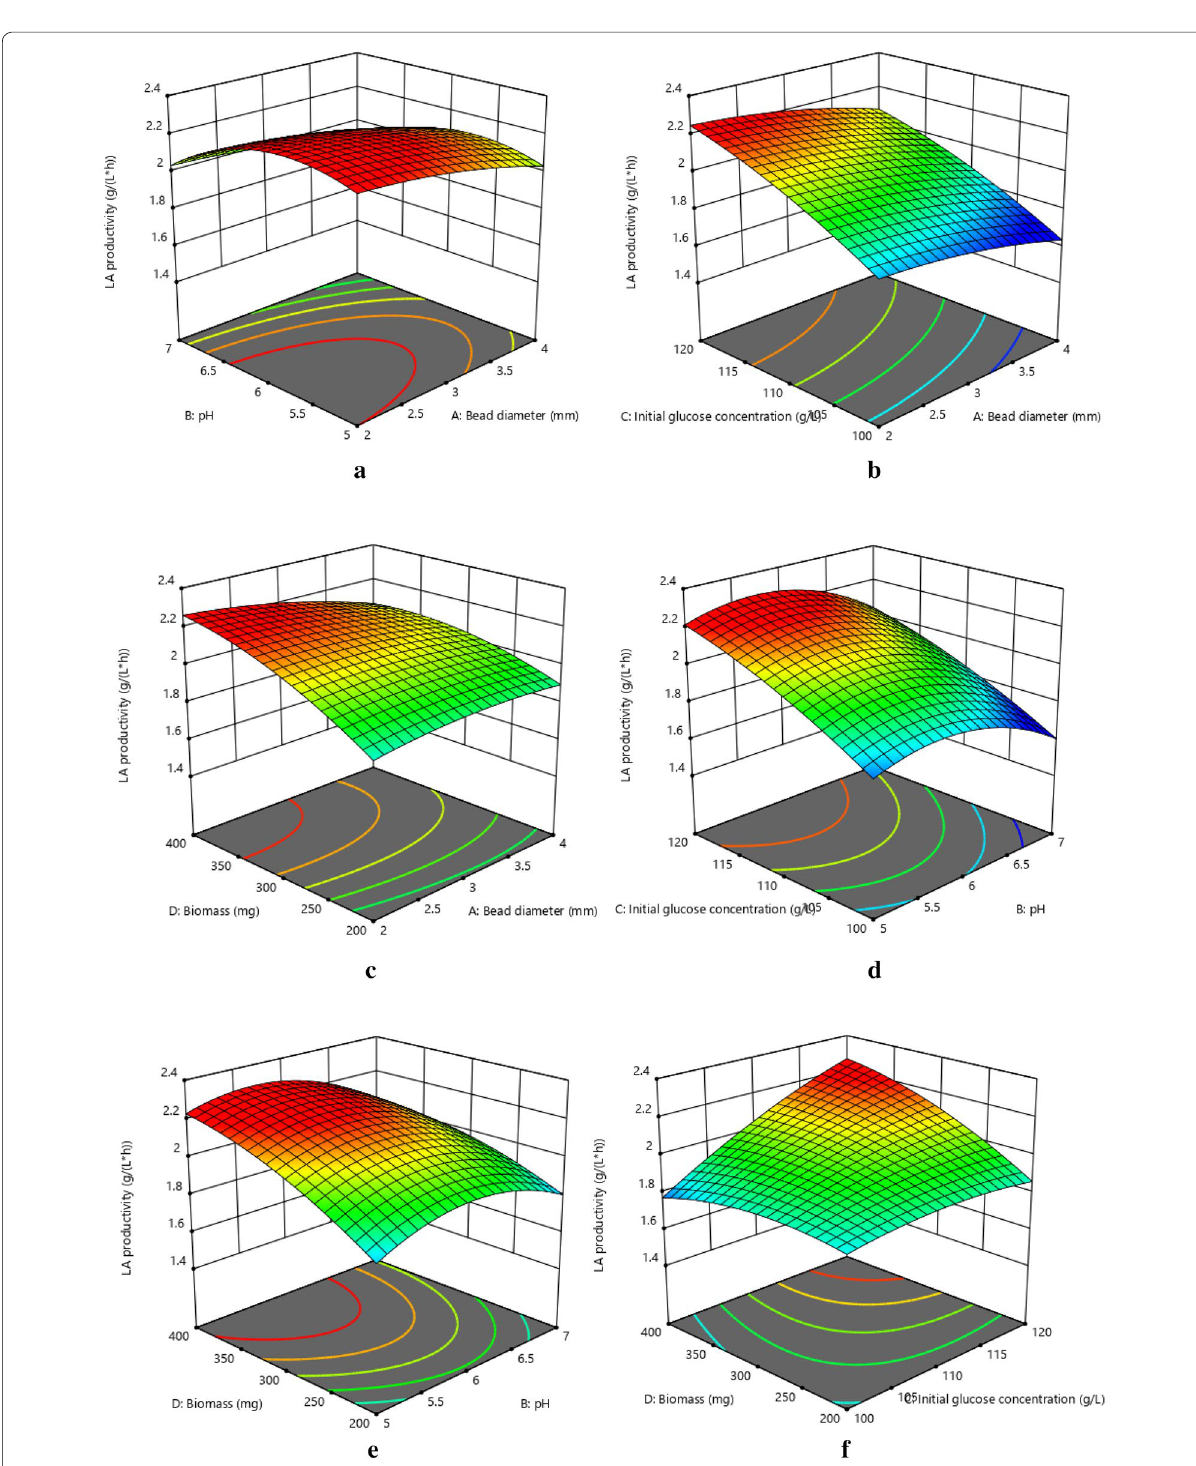
Fig. 2 Response surface of LA productivity affected by a bead diameter and pH at 119.6 g/L initial glucose concentration and 377.4 mg biomass (CDW); b bead diameter and initial glucose concentration at pH 5.21 and 377.4 mg biomass (CDW); c bead diameter and biomass at pH 5.21 and 119.6 g/L initial glucose concentration; d pH and initial glucose concentration at 2.0 mm bead diameter and 377.4 mg biomass (CDW); e pH and biomass at 2.0 mm bead diameter and 119.6 g/L initial glucose concentration, and f initial glucose concentration and biomass at 2.0 mm bead diameter and pH